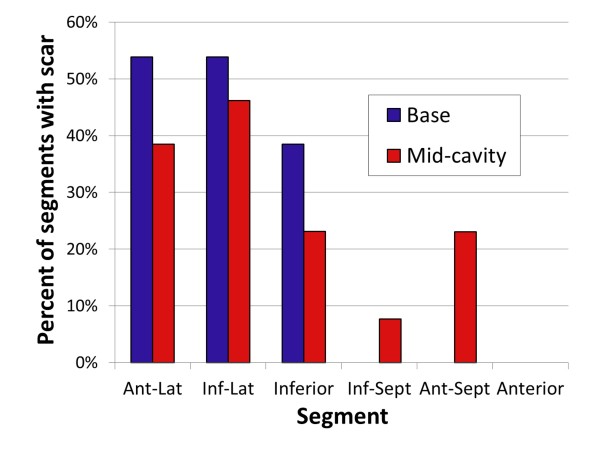
Distribution of myocardial scar in basal and mid-cavity segments. The bar graph shows inferolateral, inferior, and anterolateral predominance of scar, as well as the distribution of scar between basal and mid-cavity segments. Ant-Lat = anterolateral; Inf-Lat = inferolateral; Inf-Sept = inferoseptal; Ant-Sept = anteroseptal.